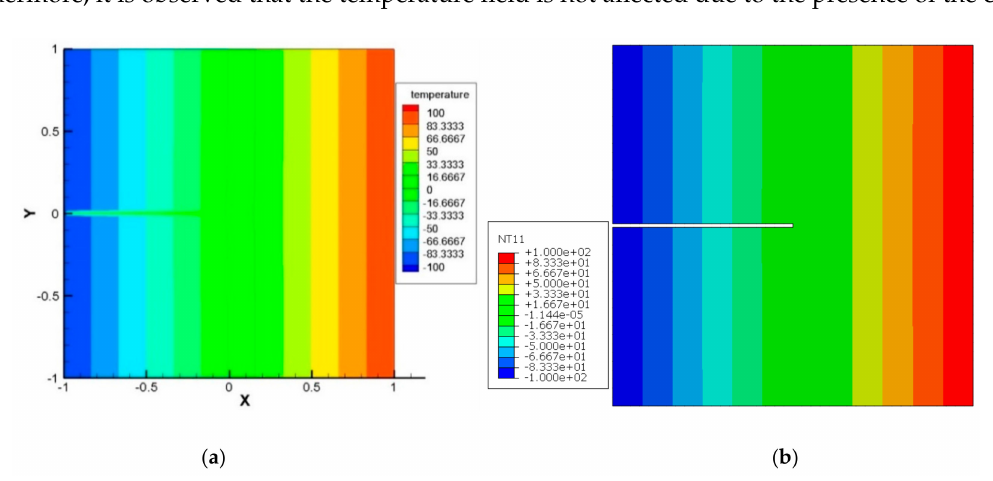
Figure 13. Temperature contour in case of edge crack, at t = 100 s. ( a ) PD result; ( b ) FEM